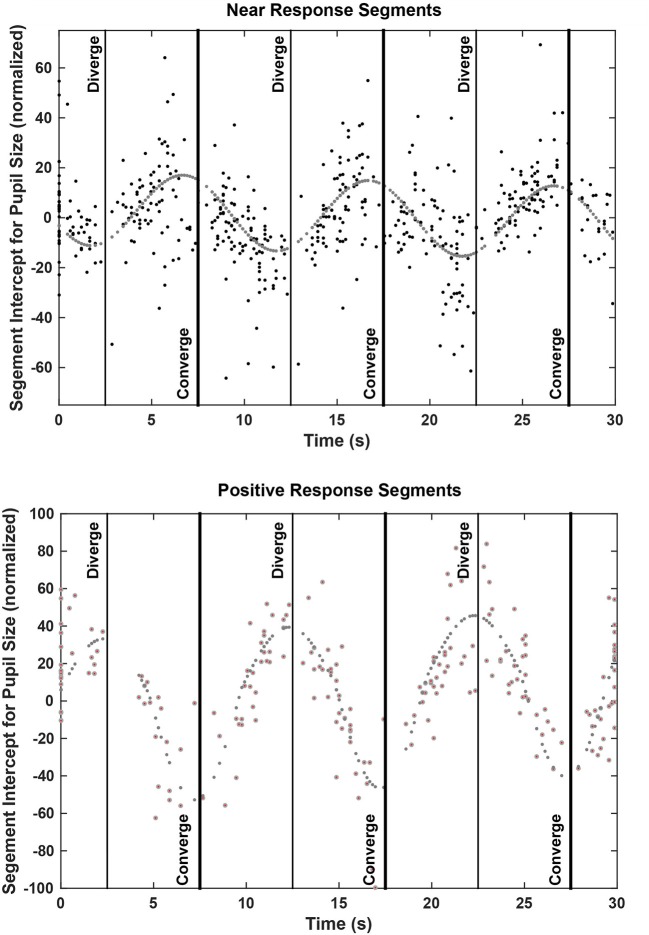
Plots of the pupil size intercepts across all subjects for linear segments of coordinated eye movement and pupil vergence accommodation patterns. The segment intercept is plotted at the onset of the segment; the stimulus times for maximum divergence and convergence are shown by vertical lines.